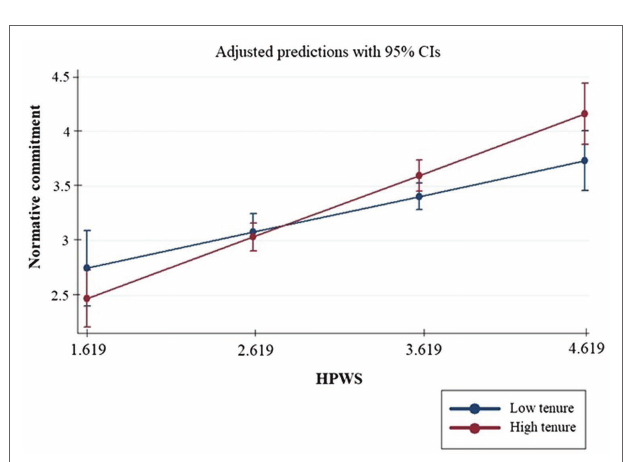
FIGURE 3 | Interaction plot—normative commitment.